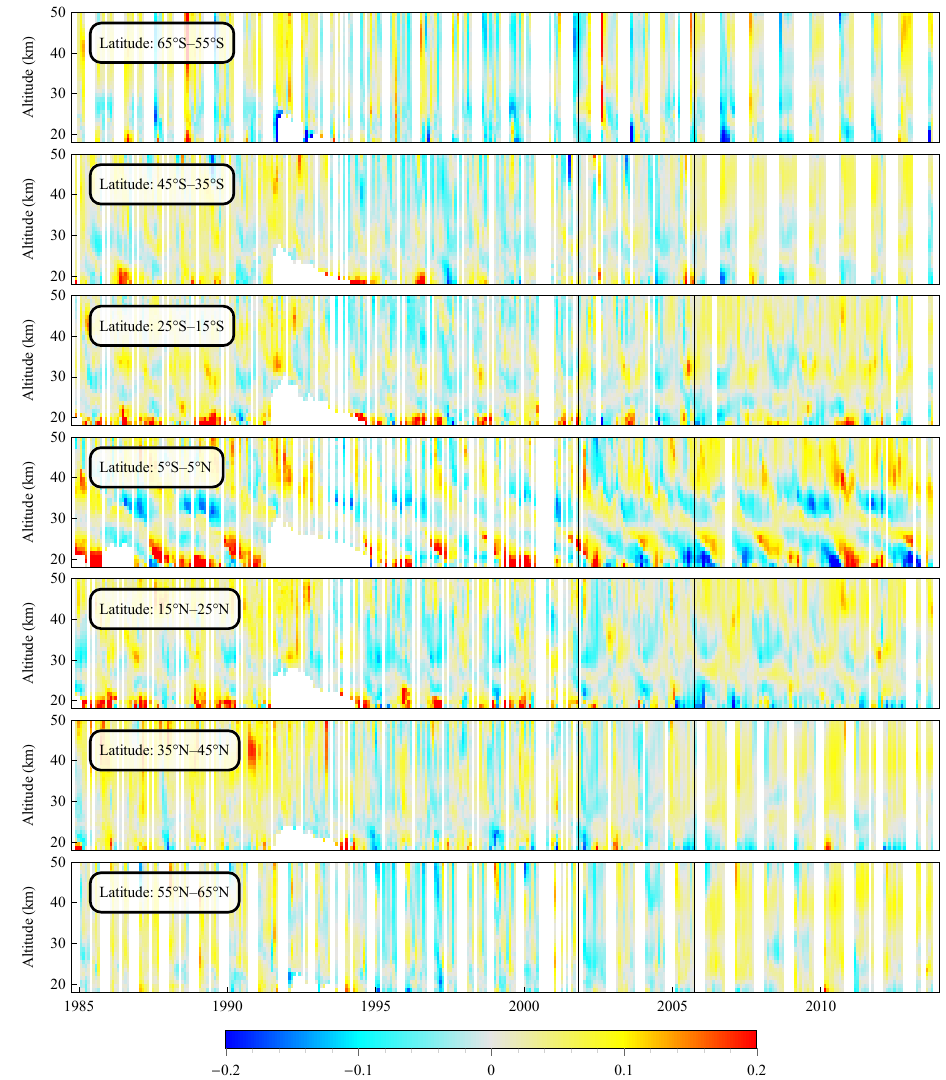
Figure 4. Merged relative ozone anomaly for selected latitude bins. The overlap period is indicated with the black bars. Missing profiles, shown in white, occur when neither instrument samples a given month. Other periods of missing data confined to the lower stratosphere are due to screening of the SAGE II data for high aerosol extinction during large volcanic eruptions. The magnitude of the relative ozone anomaly is strongest over the tropics, where the downward propagating QBO signature is clear. In each latitude bin, a broad minimum in ozone can be seen between 1994 and 2005, particularly in the upper